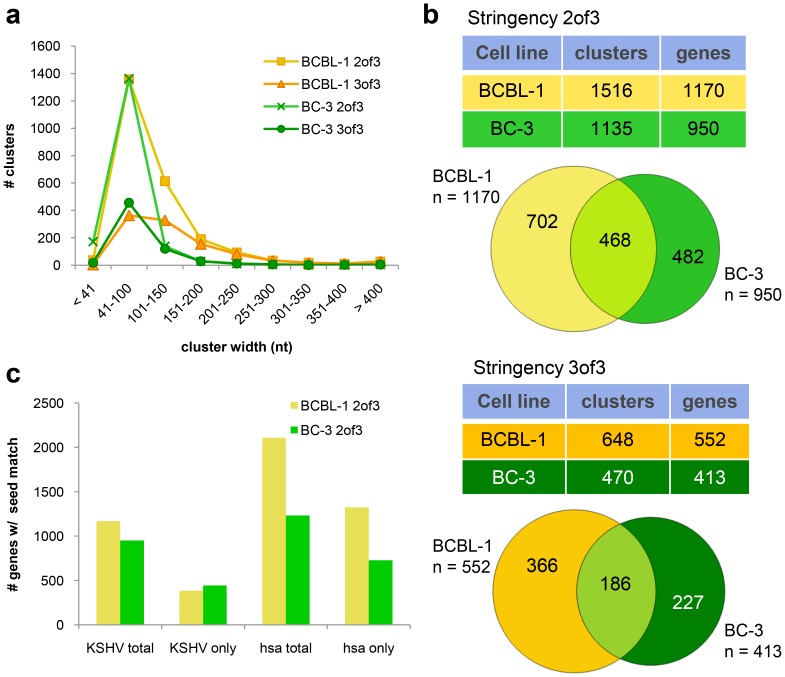
Analysis of sequencing read clusters obtained by Ago HITS-CLIP.mRNA libraries were analyzed for the presence of overlapping clusters of reads (super clusters) between BRs. Super cluster search was performed at two stringencies: i) super clusters present in 2 of 3 BRs (2of3), or ii) in all three BRs (3of3). The resulting super clusters were screened for miRNA seed match sites (nt 2–8) A: Cluster width distribution of super clusters containing any of the 25 (BCBL-1) or 23 (BC-3) KSHV miRNA seed matches; this analysis includes all super clusters aligning to annotated transcripts with a coverage of at least 2 copies/cluster per 106 reads. Clusters listed multiple times due to different KSHV miRNA seed matches in the same cluster were counted only once. B: Number of potential KSHV miRNA targets identified by Ago HITS-CLIP for the top18 KSHV miRNAs in BCBL-1 and the top16 in BC-3. Counted are all clusters (and corresponding number of genes) in BCBL-1 and BC-3 that passed the filtering criteria in (A) and have a cluster width of 41–300 nt. Venn diagrams show the number of unique and overlapping genes between BCBL-1 and BC-3 that are targeted by KSHV miRNAs. C: Comparison of seed match occurrence for the top18 (BCBL-1)/top16 (BC-3) KSHV miRNAs and the top30 human miRNAs in BCBL-1 and BC-3. ‘KSHV total’: all genes targeted either exclusively by KSHV miRNAs, or contain additional human miRNA seed matches; ‘KSHV only’: genes targeted exclusively by KSHV miRNAs; ‘hsa total’ and ‘hsa only’ correspondingly. Note that the number of genes targeted by KSHV miRNAs differs only slightly between BCBL-1 and BC-3 despite the strong overrepresentation of KSHV miRNAs associated with Ago in BC-3 (see Figure 1G). The number of genes targeted by human miRNAs, however, is significantly higher in BCBL-1, reflecting the much higher number (and variety) of human miRNAs associated with Ago in BCBL-1.